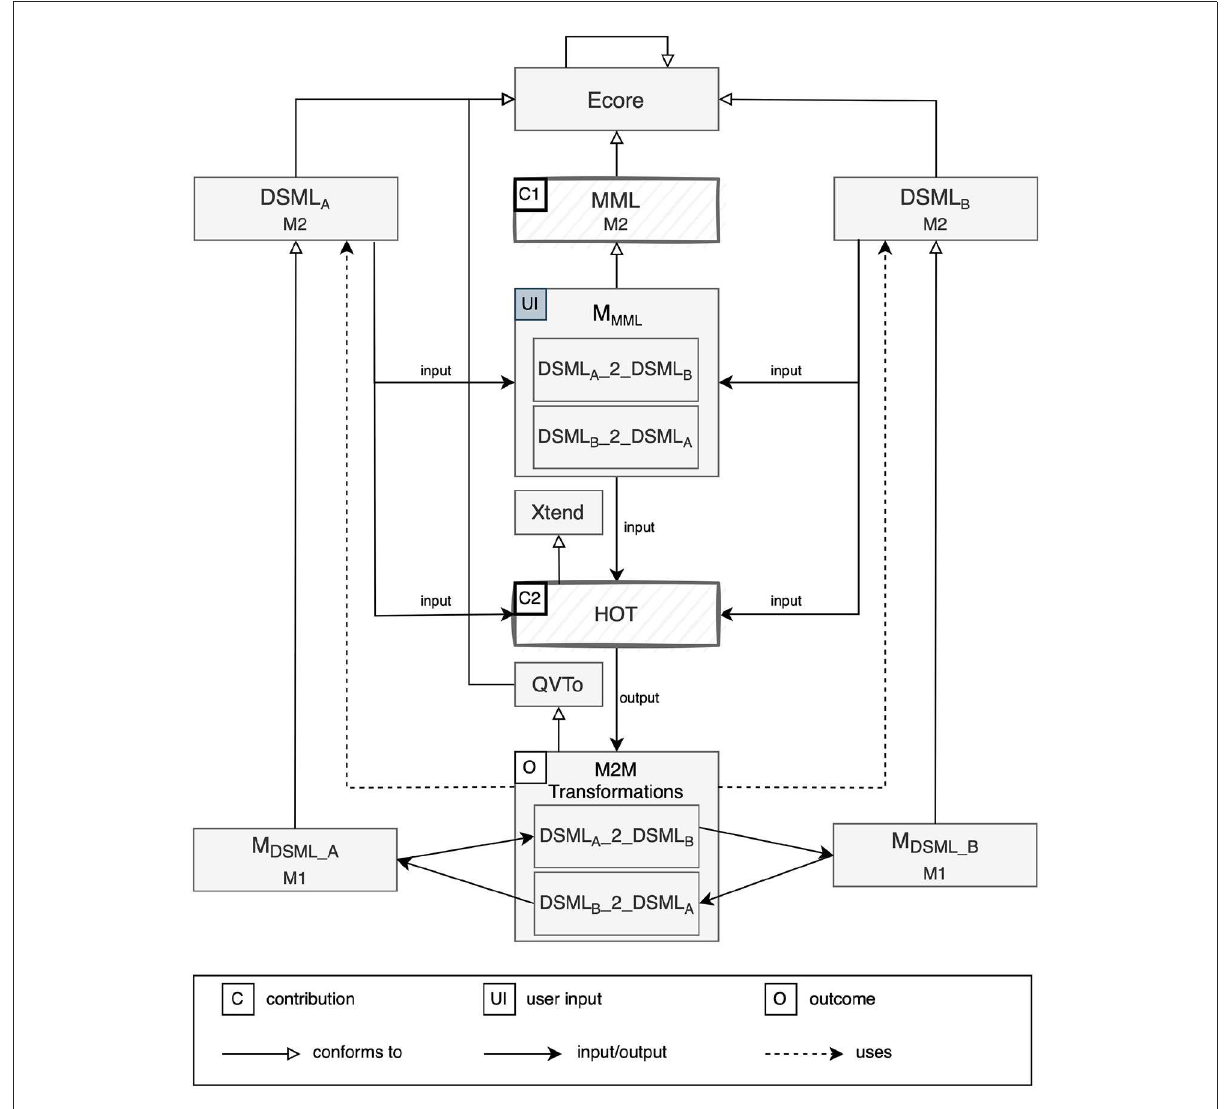
FIGURE1 Semi-automatic synchronization